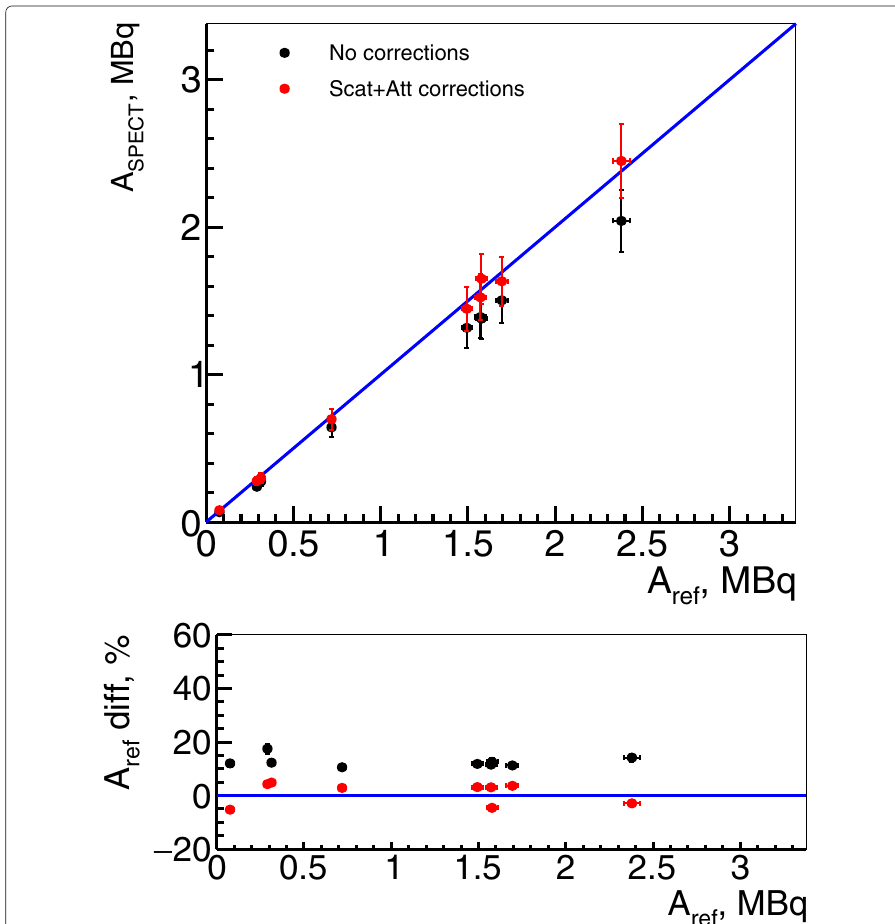
Fig. 7 Activity from SPECT images in ex vivo studies (kidneys). Ex vivo measurements on right kidneys of 111 In activity for uncorrected images in black and with only scatter and attenuation correction in red. The PVE corrections were not applied as volume of interest containing a kidney, and a formol was large enough to take into account this